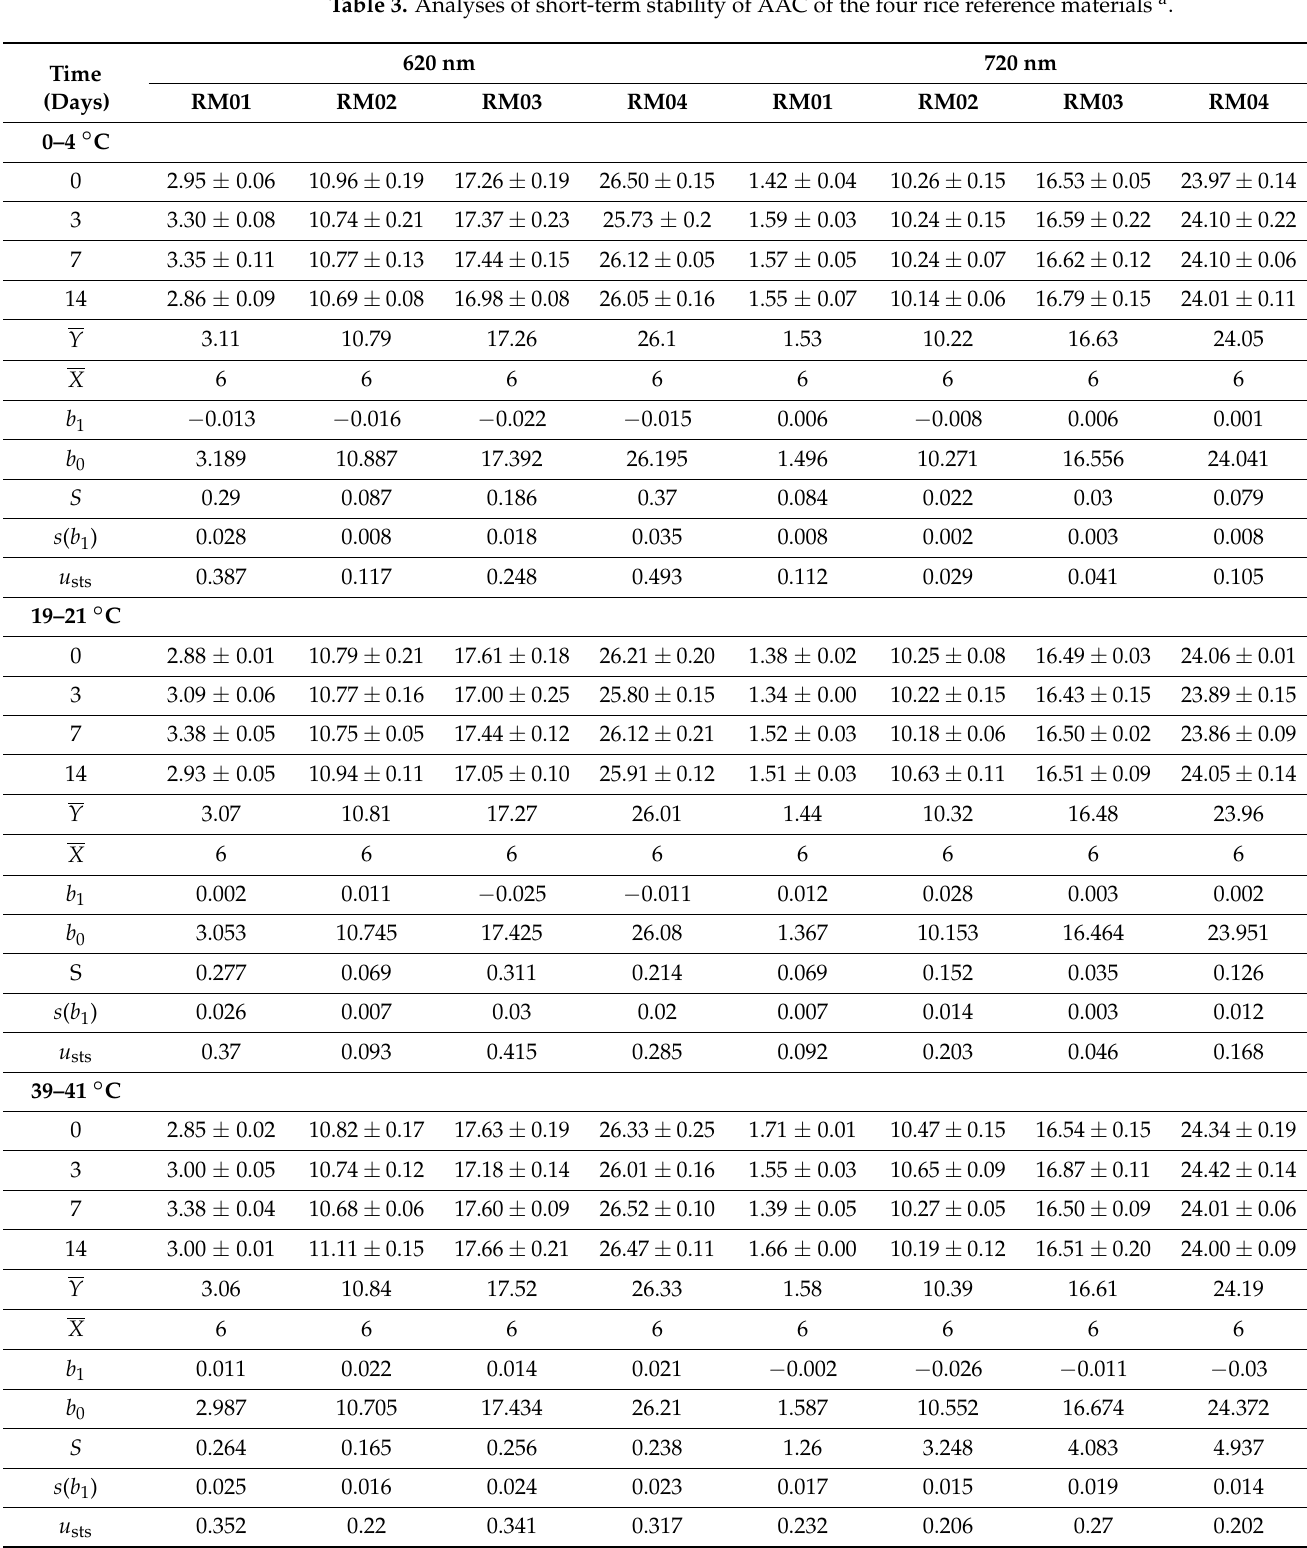
Table 3. Analyses of short-term stability of AAC of the four rice reference materials a